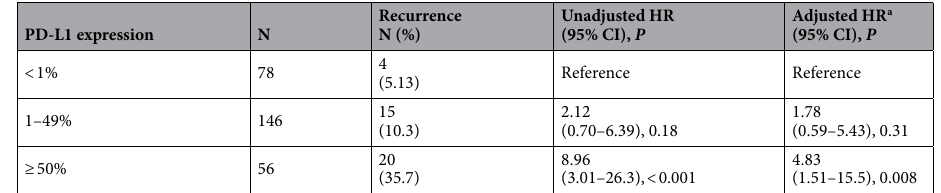
Table 2. The Cox proportional hazards analysis of RFS according to the PD-L1 expression. RFS recurrence- free survival, PD-L1 programmed death-ligand 1, HR hazard ratio, CI confidence interval, EGFR epidermal growth factor receptor gene. a Adjusted by pathological stage, histological type, adjuvant chemotherapy and EGFR mutation status.